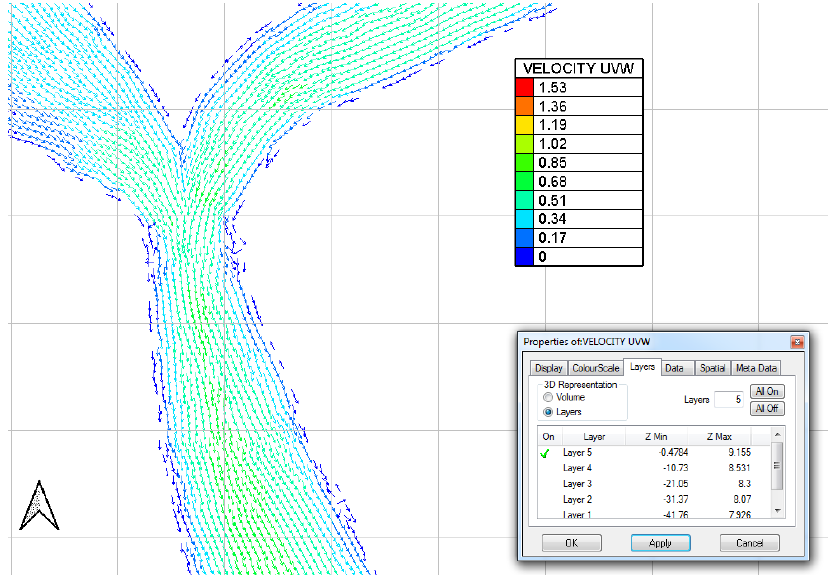
Figure 10. Average flow velocity (VELOCITY UV) in the dry season in 2017 at the surface (m/s).